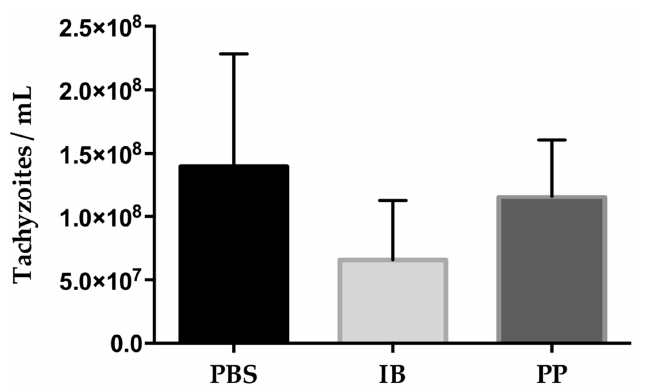
Figure 2. Quantification of T. gondii RH tachyzoites in peritoneal fluid. The parasitic load was reduced by 53% in the group treated with immunobiotic and 17.3% in those treated with paraprobiotic compared to the control group treated with PBS. Data were combined from two individual experiments with three to five mice per group. Values represent the means ± SD. No significant di ff erence between treatments. PBS) phosphate bu ff ered saline; IB) immunobiotic; PP)